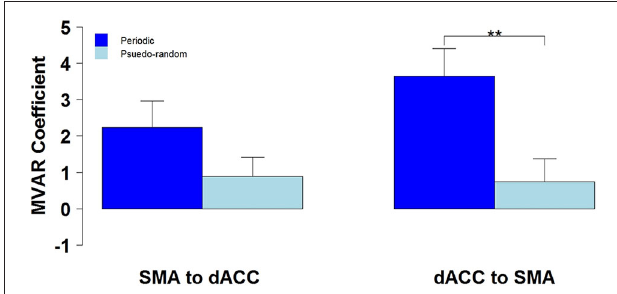
FIGURE 4 | The group mean and standard error of influence in both directions between the 2 ROIs (SMA to dACC, dACC to SMA) for Periodic (dark blue) and Pseudo-random (light blue) task conditions . Post hoc paired t-tests revealed that the influence from dACC to SMA was significantly greater for Periodic than Pseudo-random conditions, but that the influence from SMA to dACC did not significantly differ (** p < 0.01).